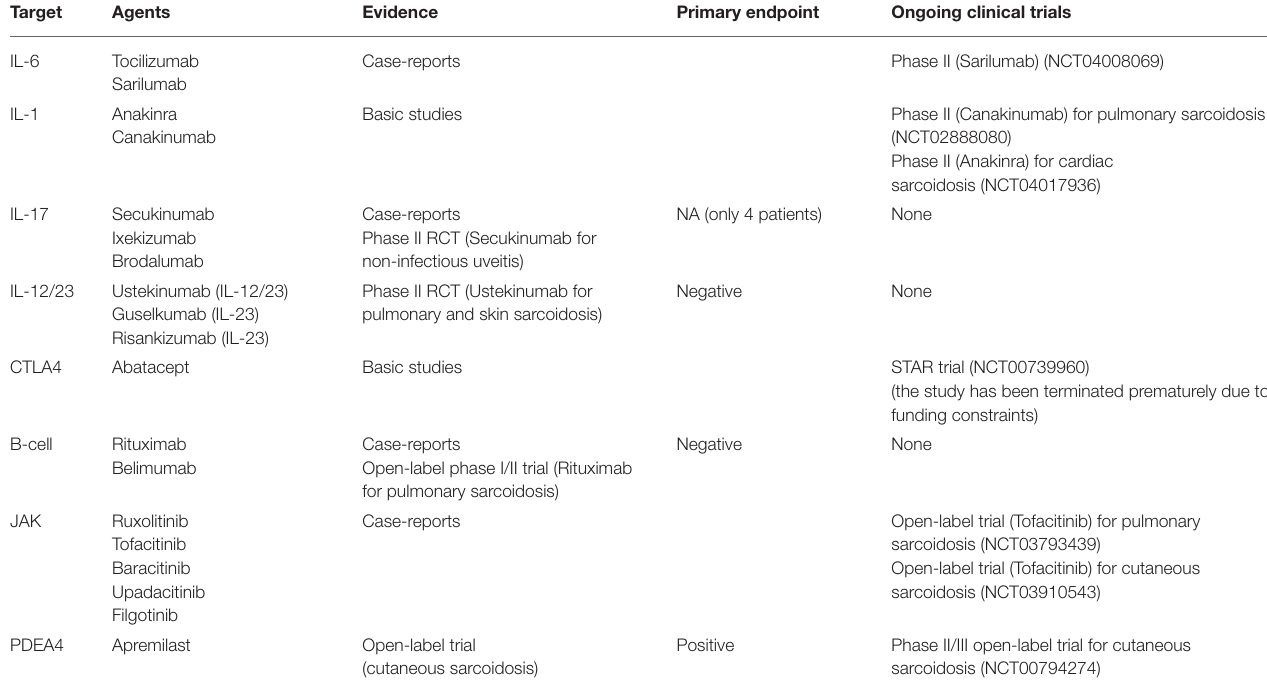
TABLE 1 | Current data on the potential therapeutic targets in refractory